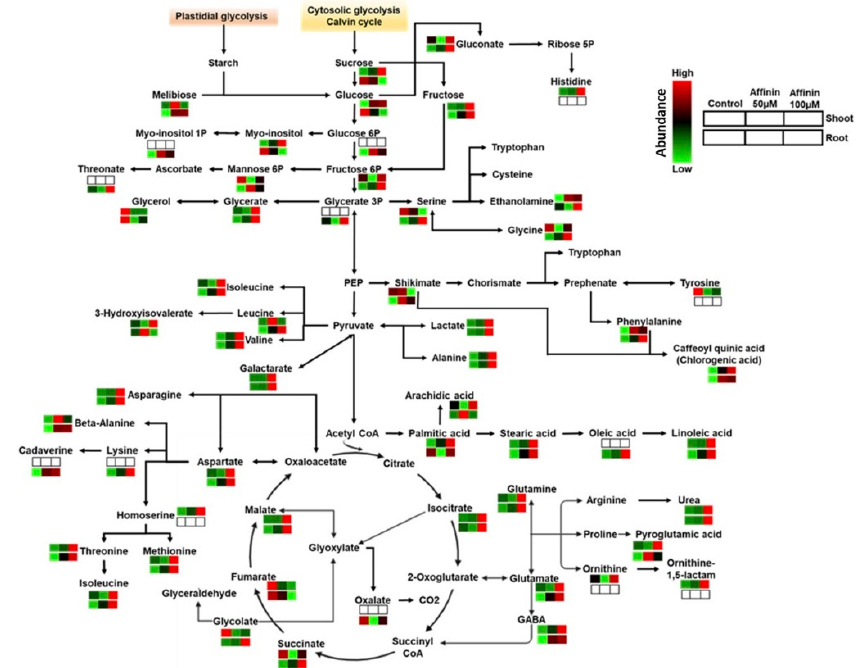
Figure 6. Core metabolism overview of metabolic changes in shoots and roots induced by affinin treatments. Pathways were constructed mapping each metabolite and function in the Kyoto Encyclopedia of Genes and Genomes (KEGG) database for Solanum lycopersicum -annotated pathways. Mean metabolite abundance for each sample type is showed in red for higher abundance or green for lower abundance while empty boxes indicate metabolites not detected.